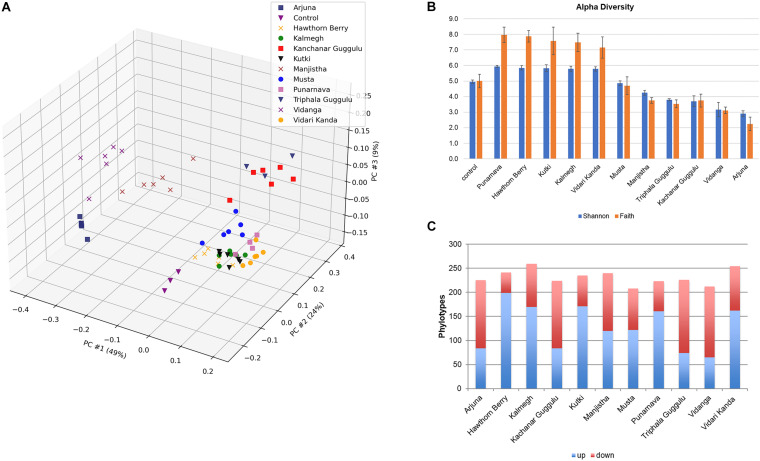
(A) Principal Components Analysis (PCoA) based on weighted UniFrac distance, β-diversity. Control cultures compared to cultures supplemented with medicinal herbs. (B) Shannon α-diversity of herb-supplemented communities. Data is compared to control cultures and presented in order of decreasing α-diversity. (C) Modulatory effects of medicinal herbs. The average relative abundance of phylotypes generated in herb-supplemented cultures were compared to control cultures. Taxa displaying five-fold increased relative abundance (blue) and five-fold reduced relative abundance (red).